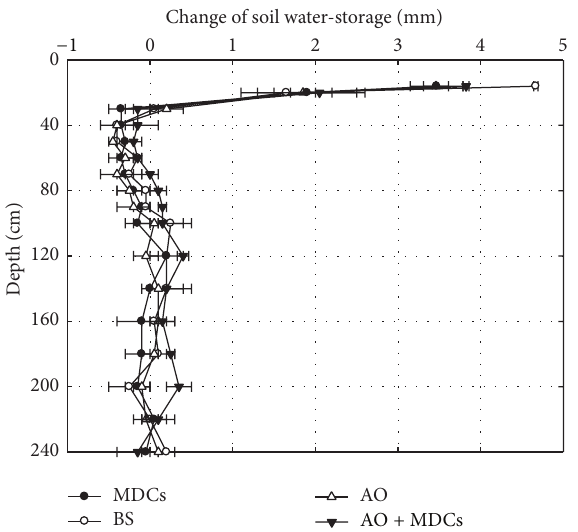
Figure 3: Change in soil water-storage of moss-dominated crusts plots (MDCs), bare sand plots (BS), Artemisia ordosica plots (AO), and Artemisia ordosica combined with moss-dominated crusts plots (AO + MDCs) after an 8.3 mm rain event.